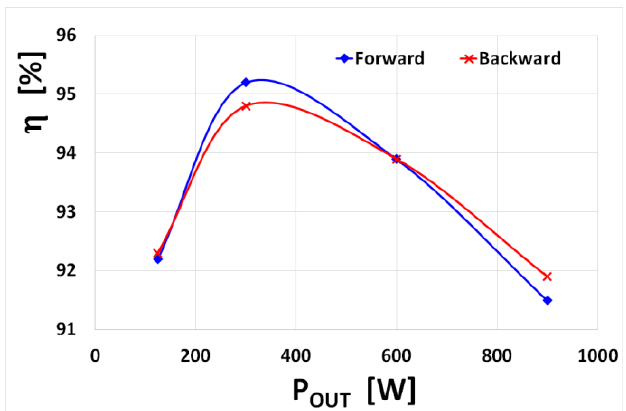
current (bottom); in ( b ), efficiency and detail of average voltage and current values.